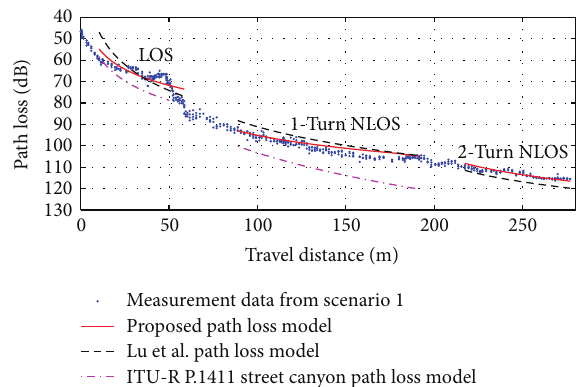
Figure 8: Comparison of the proposed path loss model (fitting to the measurement data), Lu et al. model in [6], and the ITU-R Street Canyon model [17] for Scenario 1 in Figure